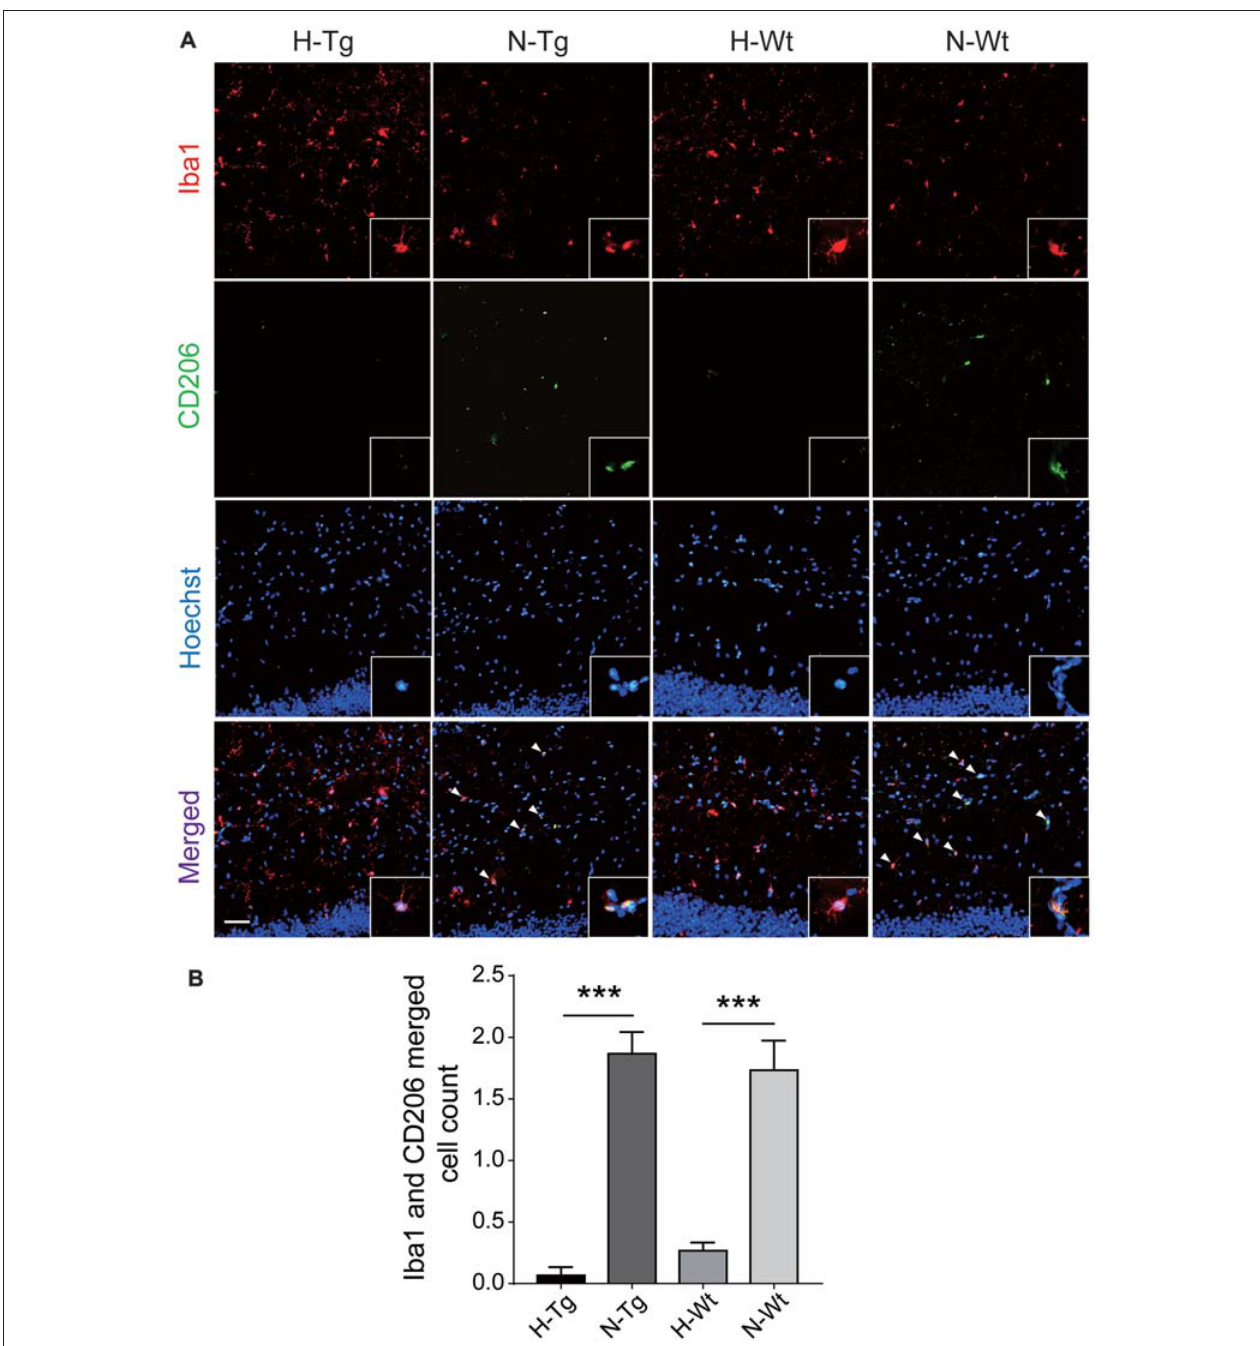
FIGURE 4 | Double immunostaining of CD206 (M2 marker) and Iba1 positive microglial cells in hippocampus. CD206 (green) and Iba (red) co-stained microglial cells (yellow, arrow head) were decreased significantly in H-Tg and H-Wt groups vs. N-Tg and N-Wt groups, respectively (A,B) . Scale bar: 50 µ m, n = 3 in each group. Data were the mean ± SEM values. ∗∗∗ p < 0.001 by one-way